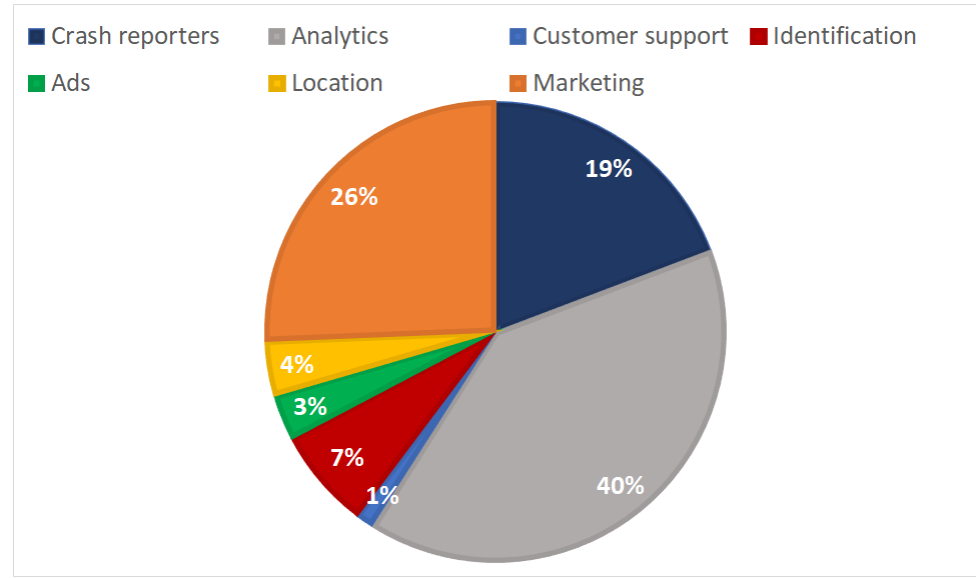
Figure 3. Allocation of trackers per